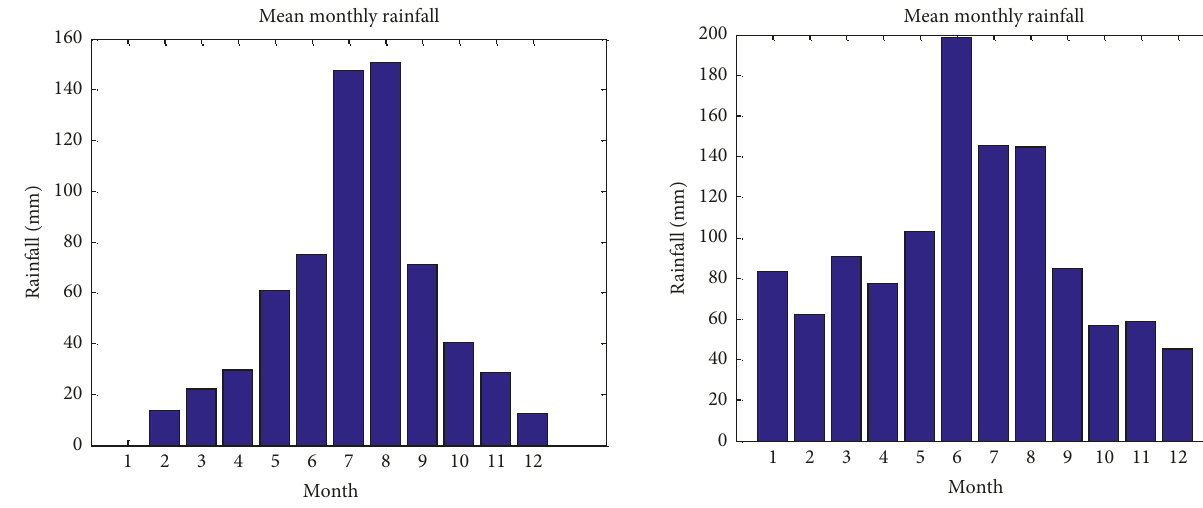
Figure 3: Histogram of the mean monthly rainfall in Suzhou, China.